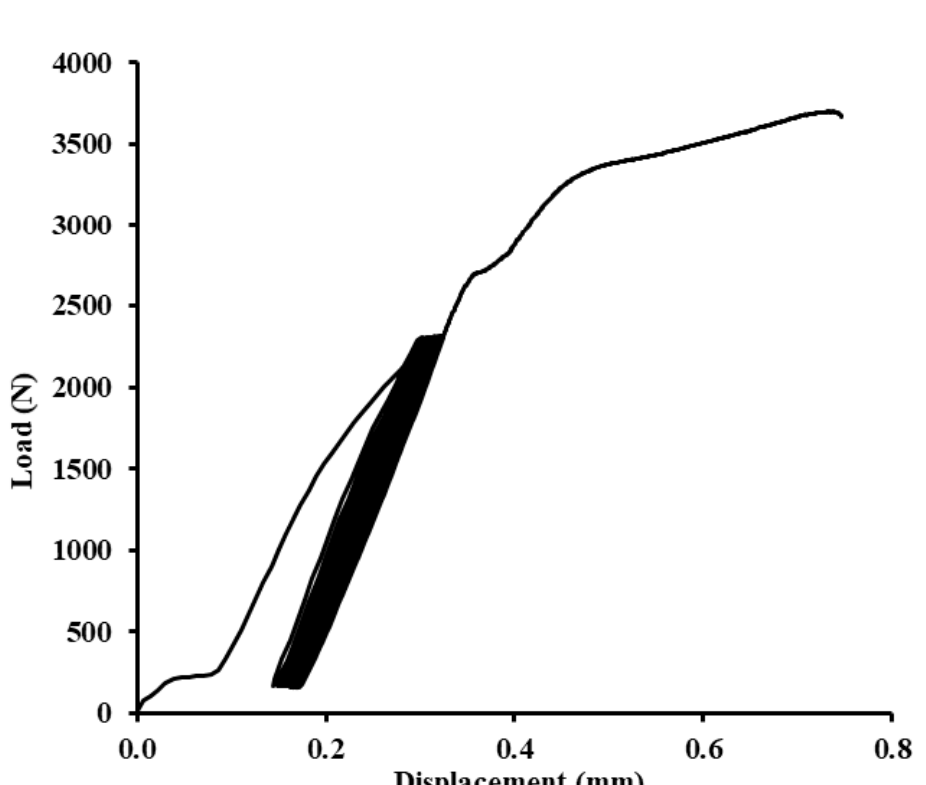
Figure 16. Quasi-static graph of adhesive bond ABFE2 with loading 5–70% (165–2307 N)—267 cycles.